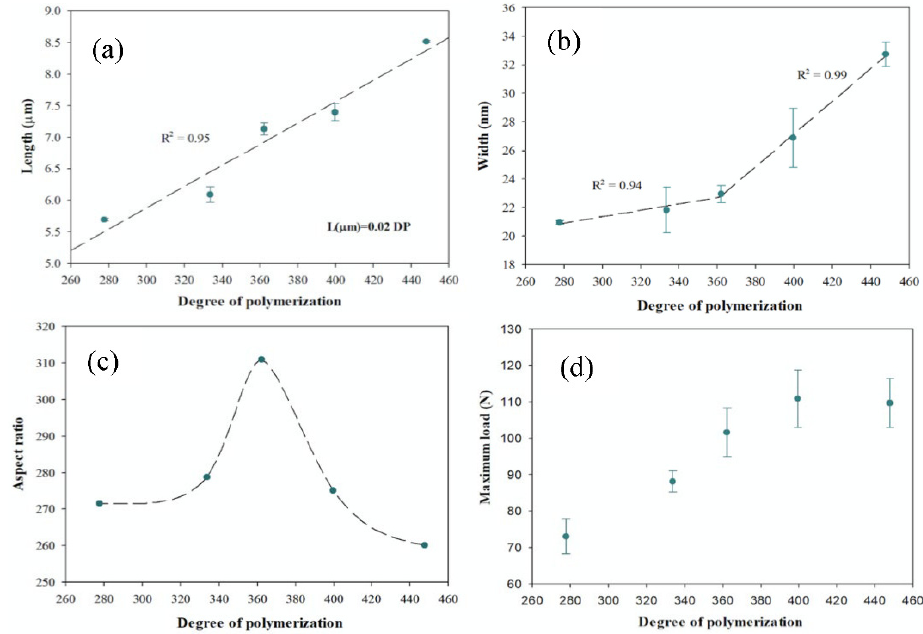
Figure 3. Morphological characteristics of CNFs and resistance of CNF films depending on the degree of polymerizationL: ( a ) length, ( b ) width, ( c ) aspect ratio, and ( d ) maximum load.